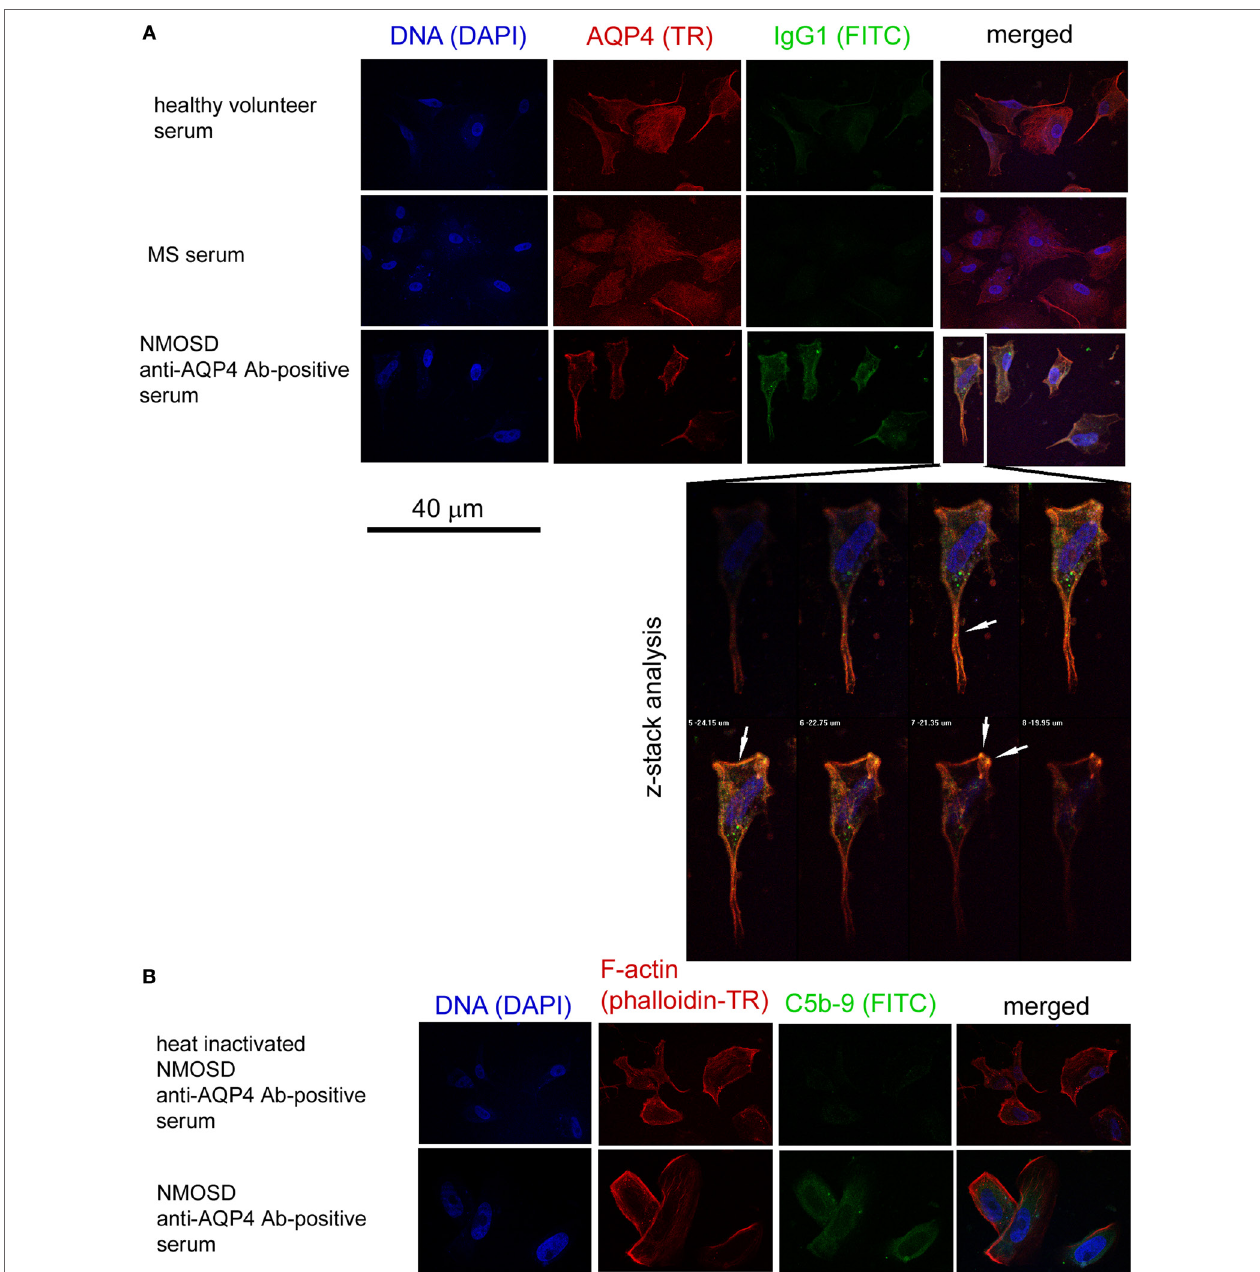
FigUre 2 | Anti-aquaporin-4 (AQP4) Ab-positive serum from neuromyelitis optica spectrum disorder (NMOSD) patients activates membrane attack complex deposition on the surface of human astrocytes. (a) Anti-AQP4 Ab-positive serum from NMOSD patients opsonizes human primary astrocytes. Confocal z-stack microscopy analysis confirms formation of AQP4–IgG1 immunological complexes on the cell surface in astrocytes incubated with NMOSD serum. White arrows mark colocalization of AQP4 and IgG1 signals (yellow color) (b) . Binding of AQP4 receptors by autoantibodies activates classical complement cascade which can destabilize astrocytes by formation of membrane attack complex (C5b-9) [ (b) , lower panel]. Negative signal in NMOSD serum which has been previously heated causing complement inactivation (56°C, 30 min) excluded false positivity in C5b-9 ICC analysis [ (b) , upper